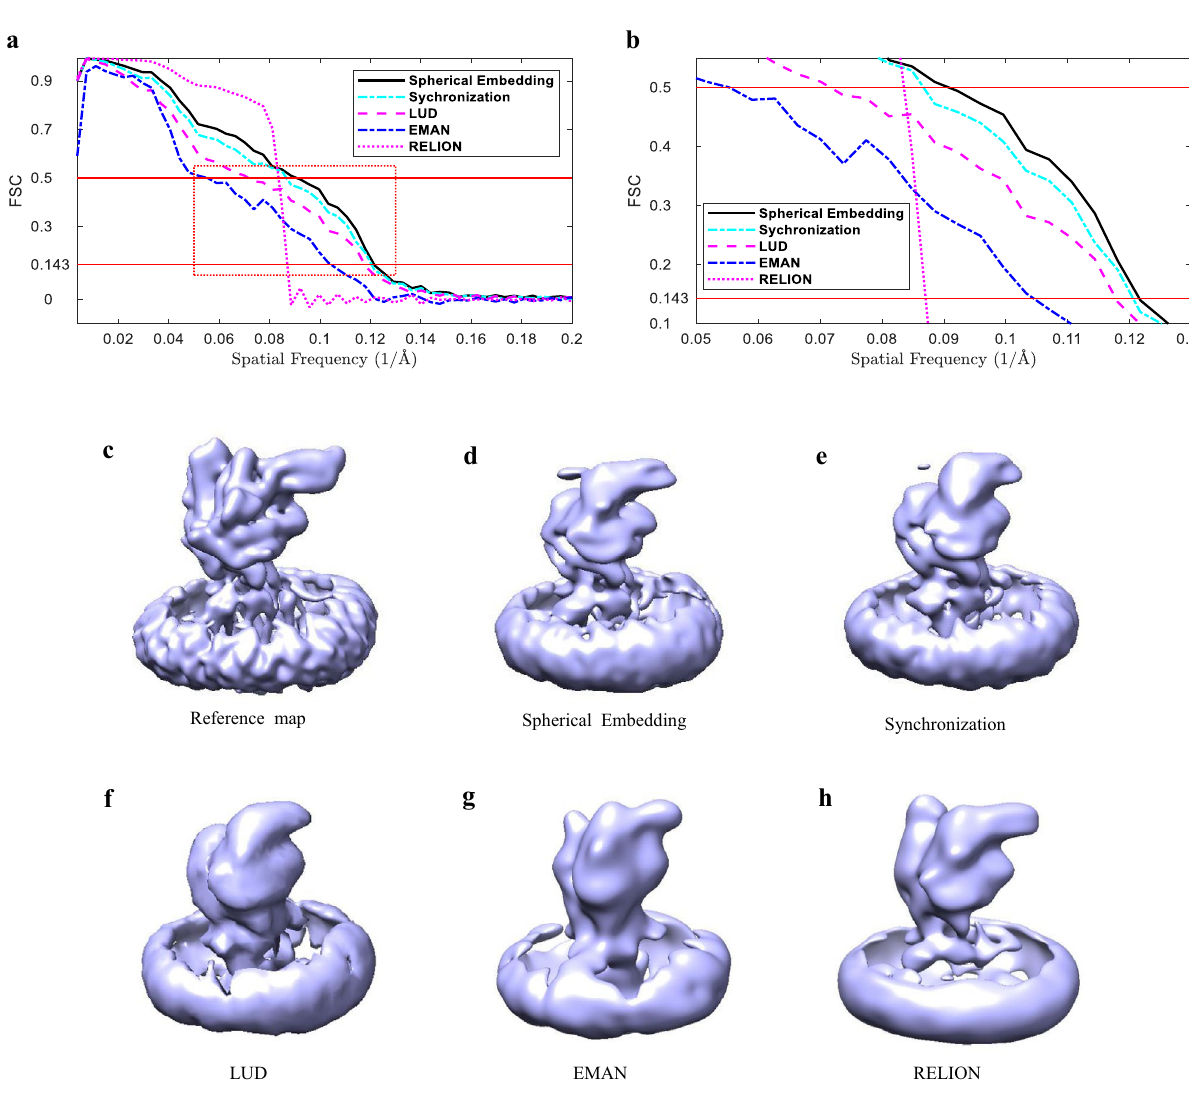
Fig. 6 Evaluation using the FSC curves and the reconstructions for the EMPIAR-10328 dataset. a Comparison of the FSC curves produced by the proposed method (Spherical Embedding), Synchronization, LUD, EMAN 2.1, and RELION-2 on the EMPIAR-10328 dataset. b The zoom-in of the red dashed rectangle region in ( a ), which shows the details of the FSC curves around the spatial frequency of 0.09 1/Å. c The reference map (EMD-22689). Others are the reconstructed maps from the class averages by: d the proposed method (Spherical Embedding), e Synchronization, f LUD, g EMAN 2.1, and h RELION- 2. The density around the transmembrane region in the lower part of the initial models of the PTCH1::T123 complex belongs to the